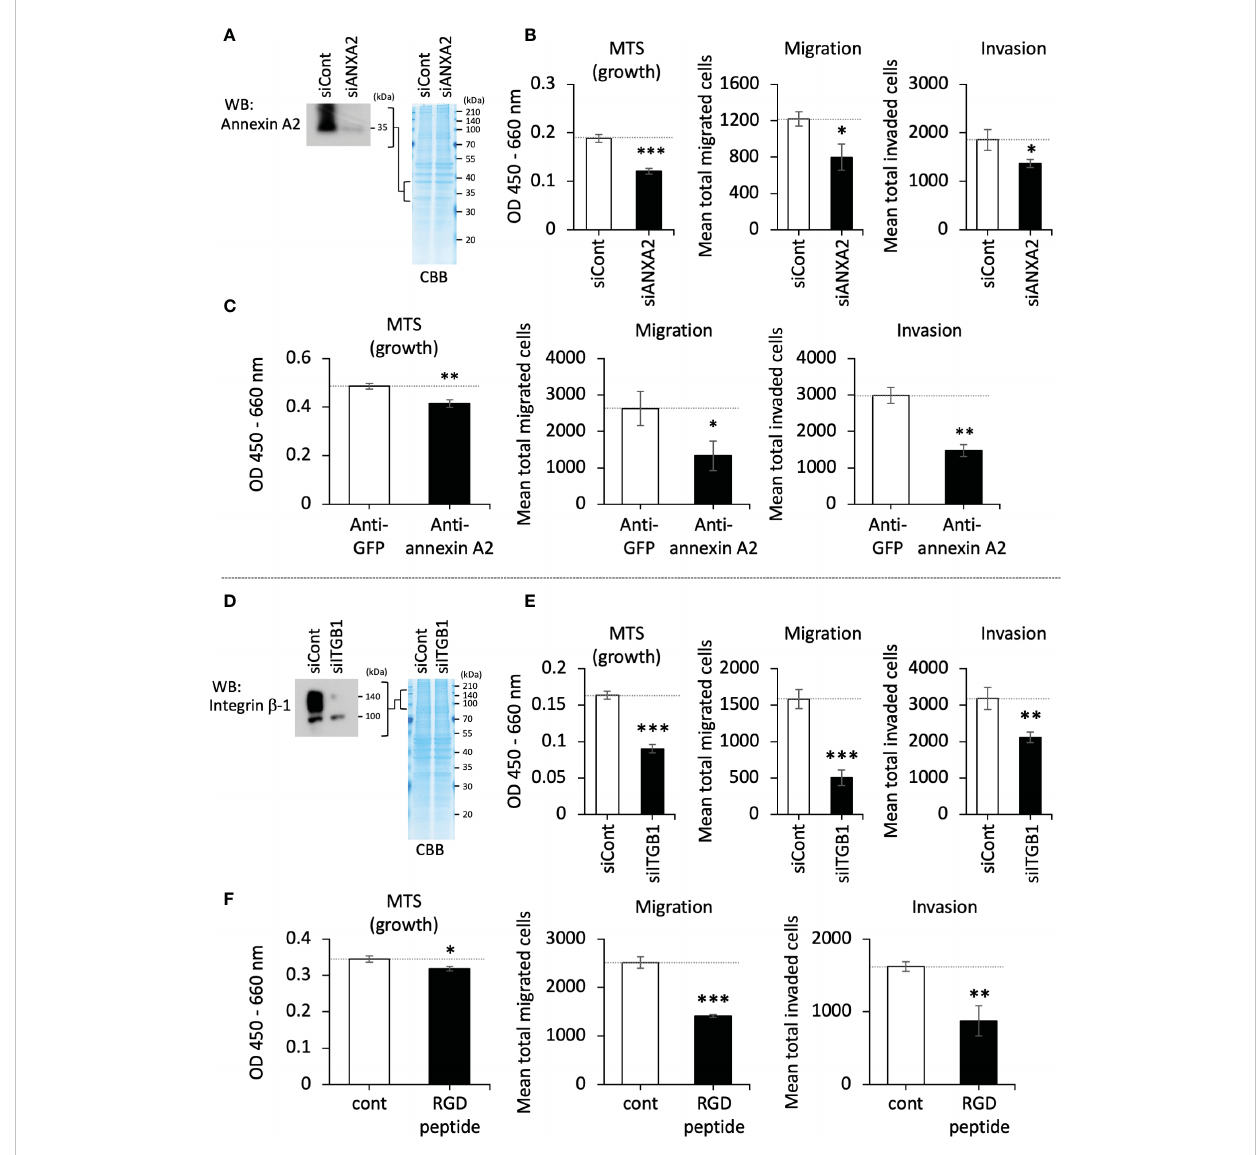
FIGURE 3 The roles of cell-surface annexin A2 and integrin b -1 on cellular growth, migration, and invasion in vitro . (A) : The siRNA-mediated lowered expression of the intrinsic annexin A2 in MDA-MB-231 cells was con fi rmed by western blotting (WB). (B) : The growth, migration, and invasion of annexin A2 siRNA (siANXA2)-treated cells. (C) : MDA-MB-231 cells were treated with annexin A2 antibody (anti-annexin A2, fi nal conc. 25 m g/mL) to block the cell-surface annexin A2. The treated cells ’ growth, migration, and invasion were then evaluated. Green fl uorescence protein (GFP) antibody (anti-GFP) developed by our laboratory ( fi nal conc. 25 m g/mL) was used as a negative control. (D) : MDA-MB-231 cells were treated with integrin b -1 siRNA (siITGB1), and the reduced expression of the protein was con fi rmed by WB. (E) : The siRNA-treated cells were evaluated as described for panel (C) (F) : RGD peptide (500 m g/mL) was used to inhibit the cell-surface integrins, and its effects on cell growth, migration, and invasion were evaluated. Data are mean±SD except for those in panels (A, D) *p<0.05, **p<0.01,